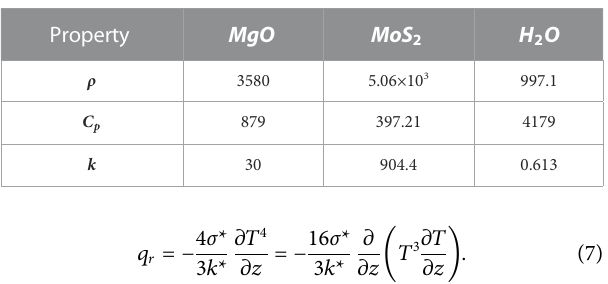
TABLE 1 Thermophysical characteristics of base fl uid and nanoparticles (Mishra and Upreti,